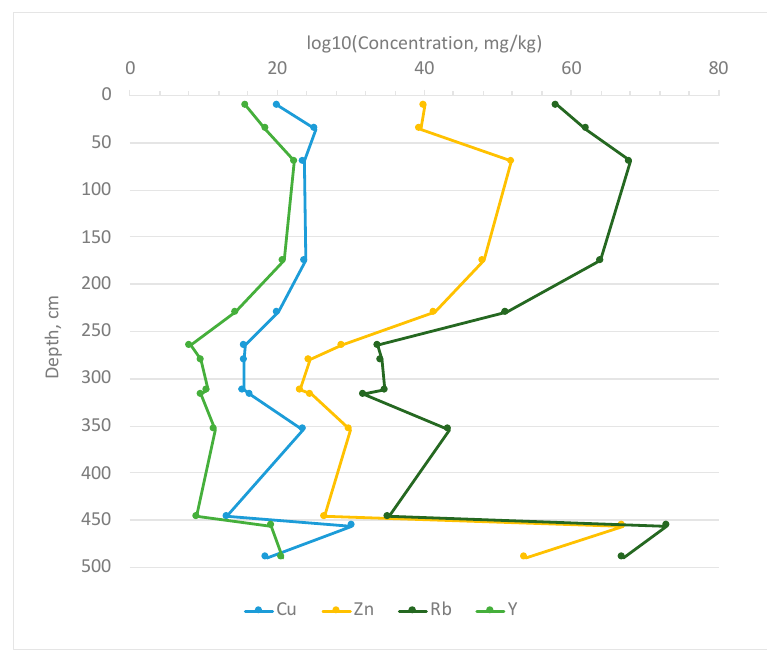
Figure 10. Trace elements (Cu, Zn, Rb, Y, Pb) distribution along the sediments (mg/kg).